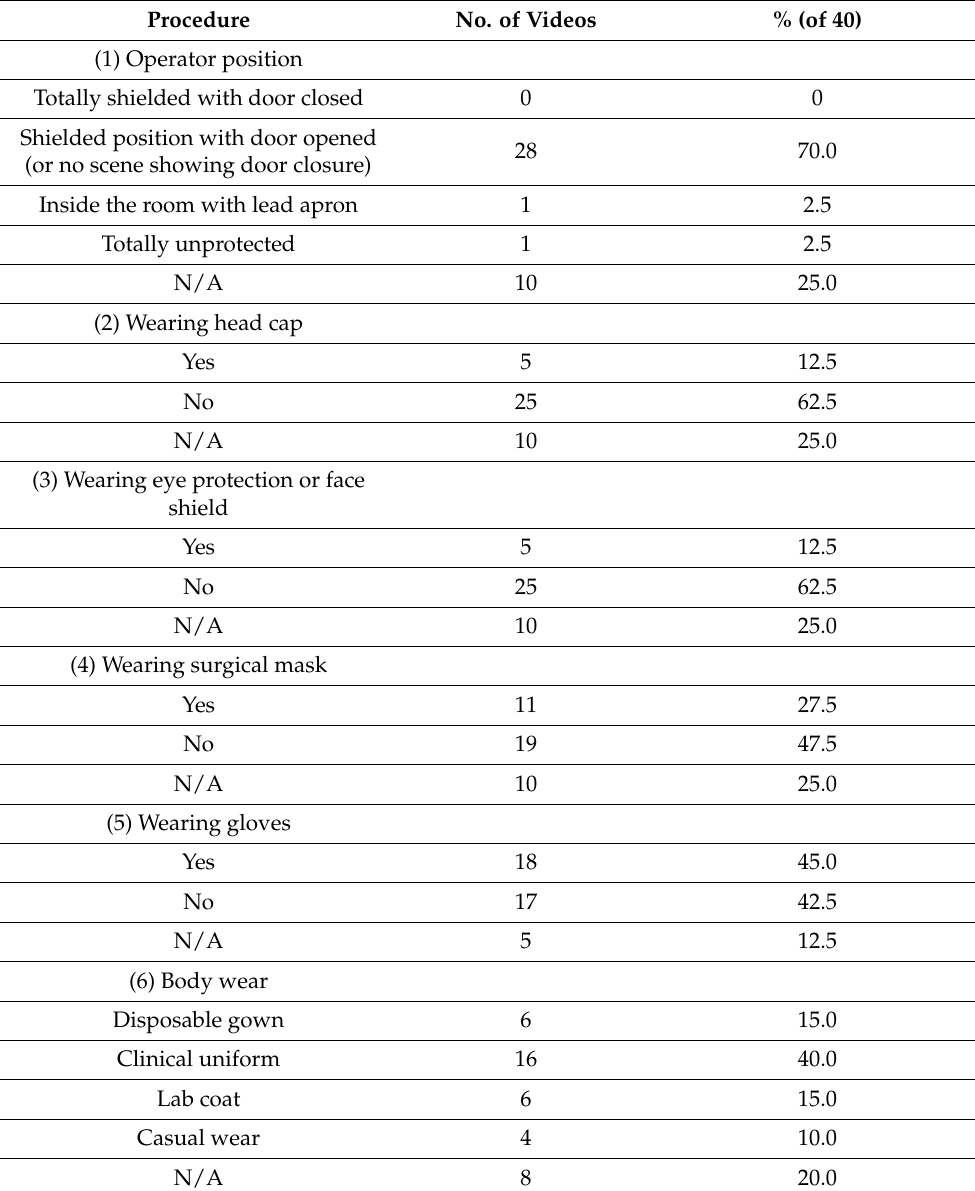
Table 3. Frequency counts of operator safety procedures.